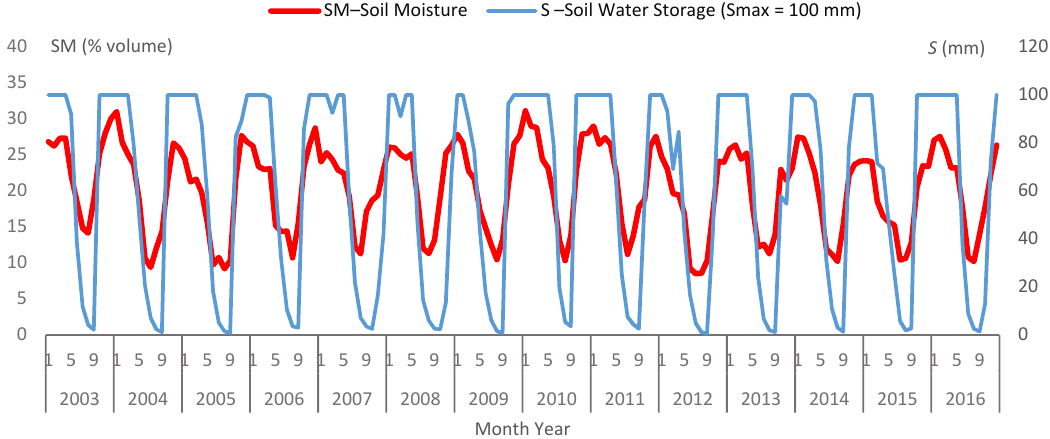
Figure 5. Monthly series of soil moisture (SM), an ESA satellite product, and soil water storage ( S ), an outcome of the Thornthwaite–Matter water balance that was computed for Bragança (Smax = 100